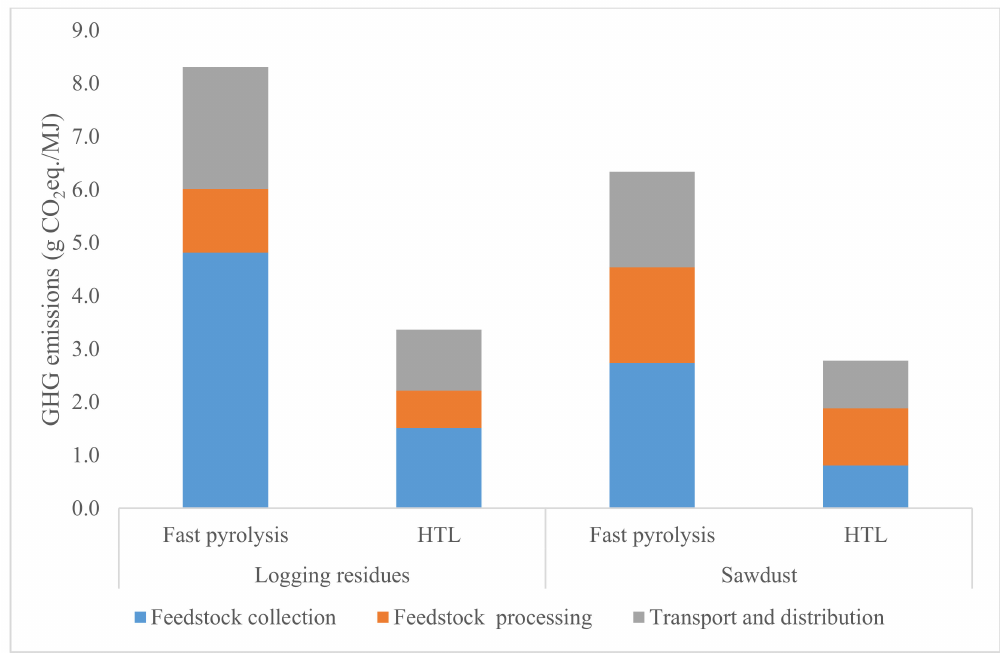
Figure 5. Impact on HVO life cycle GHG emissions by changing fast pyrolysis to hydrothermal liquefaction